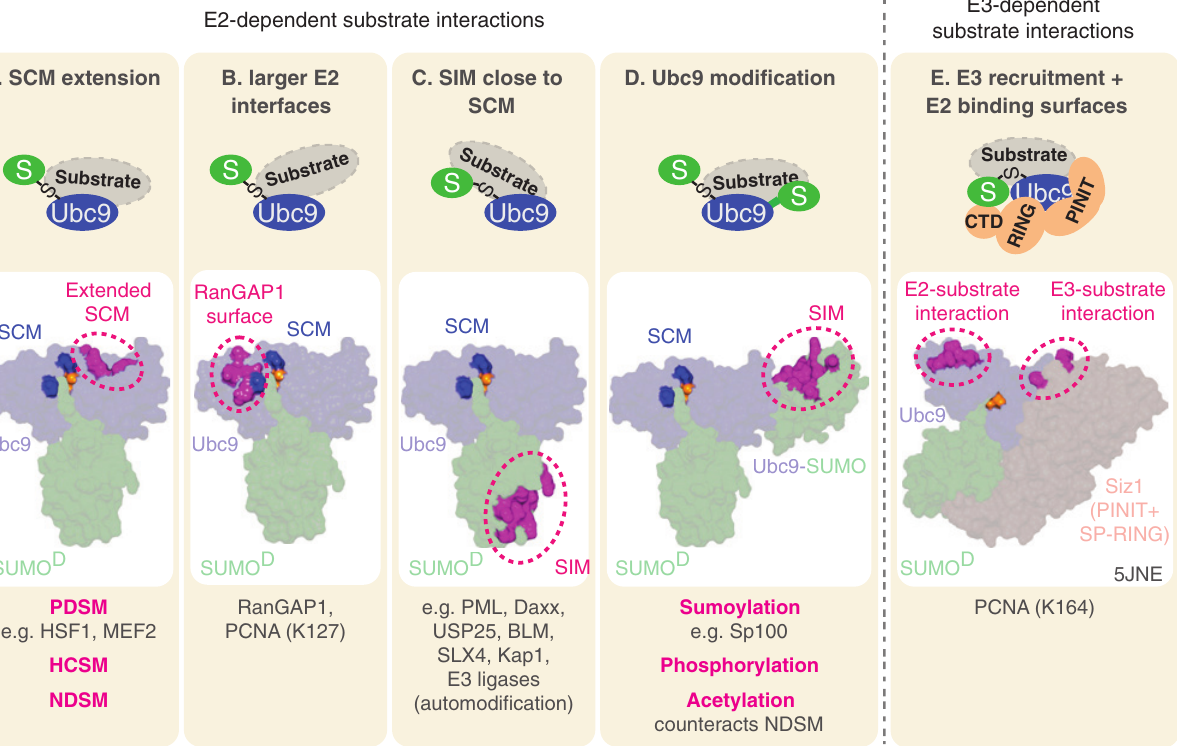
Figure 4: E2 and E3 dependent substrate